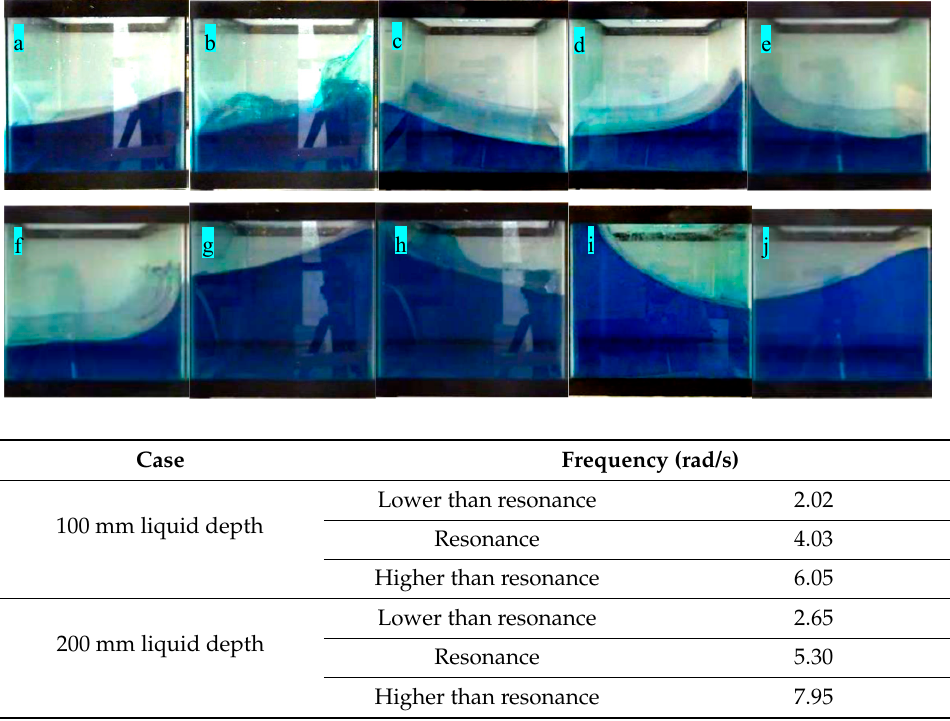
Figure 6. Higher liquid heights observed near the corners of the tank regardless of tank orientation and excitation